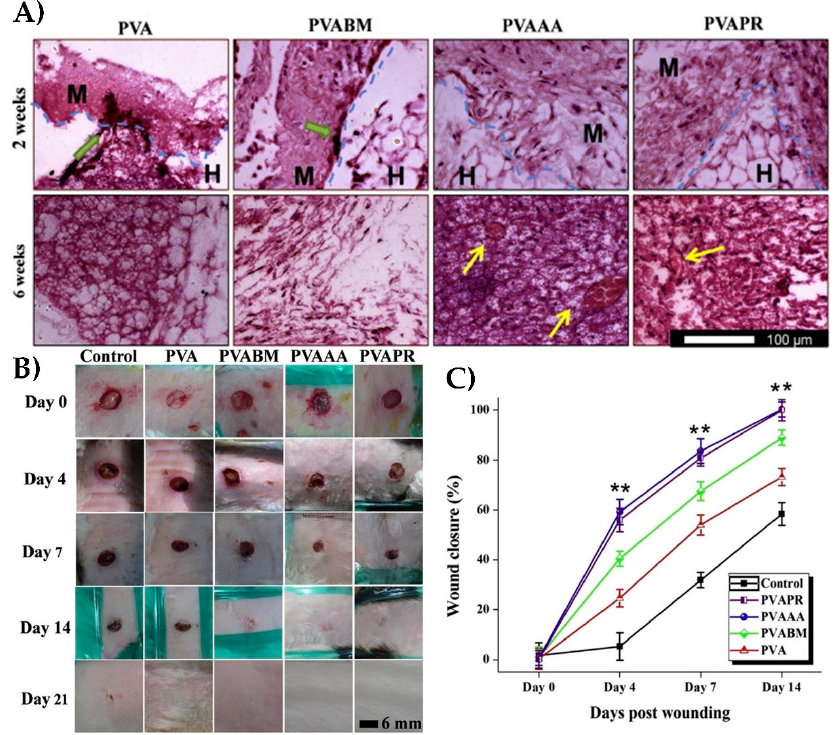
Figure 9. ( A ) Hematoxylin and eosin staining for histological analysis of subcutaneously implanted mats made of varying PVA-silk nanofiber composite fibers. Mats containing non-mulberry silk showed greater cell infiltration and proliferation compared to those made of mulberry silk or those containing only PVA. Green arrows indicate infiltrating cells at the interface of the implant, and yellow arrows indicate the development of new blood vessels. ( B ) Images of wounds on rabbits treated with PVAA-silk mats. The percentage of wound closure is quantified in ( C ) (reproduced with permission from [25], Copyright Elsevier, 2017).